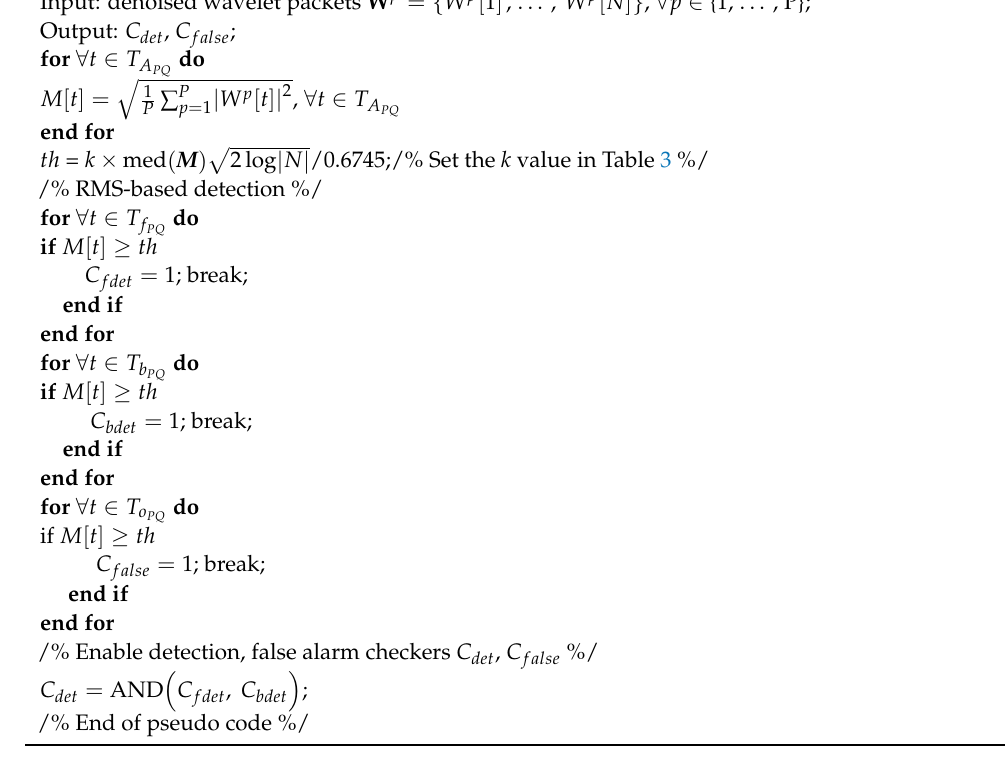
Algorithm 2. WPTM-based PQD detection using RMS